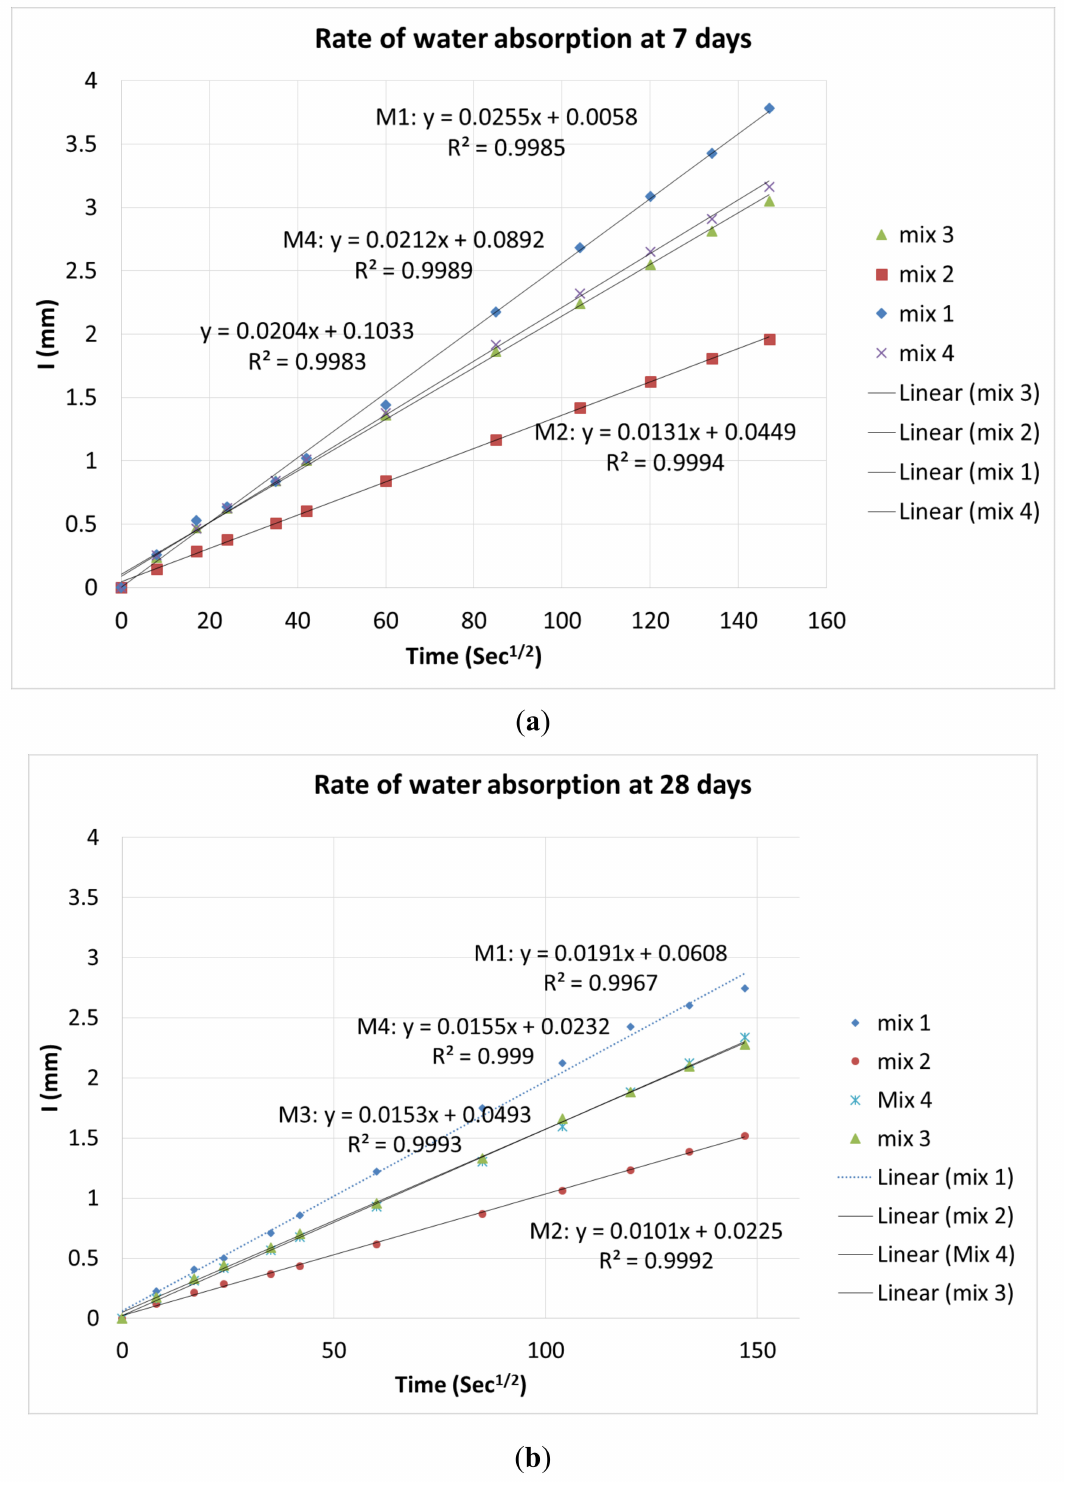
Figure 8. Rate of water absorption of green star concretes and control concrete at ( a ) 7 days and ( b ) 28